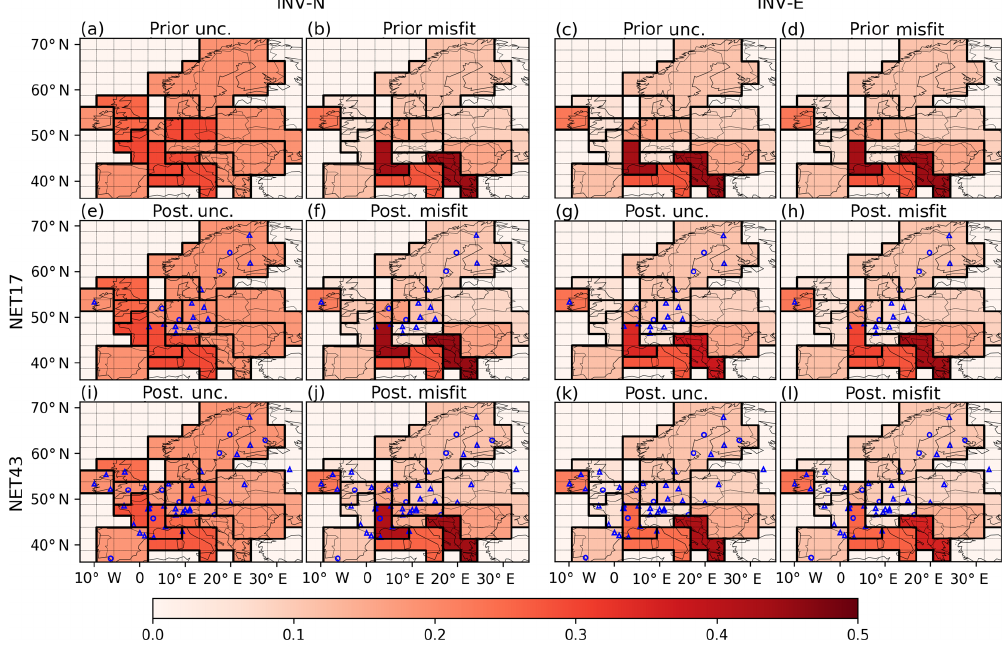
Figure 5. Average monthly relative prior and posterior uncertainties and misfits of FFCO 2 emissions over regions delineated by black lines, using the NET17 and NET43 networks and 2-week sampling for INV-N (first and second columns) and INV-E (third and fourth columns) inversions. First row shows the relative prior uncertainties and misfits. The second row shows the posterior uncertainties and misfits after assimilating 2-week mean afternoon observations from network NET17. The third row shows the posterior uncertainties and misfits after assimilating 2-week mean afternoon observations from network NET43. The dashed lines show the grid cells of the transport model LMDZv4. The dots and triangles are the locations of the observation sites where the gradients are extracted with respect to the JFJ reference site. Dots (triangles) correspond to “urban” (or “rural”) stations defined in Sect.